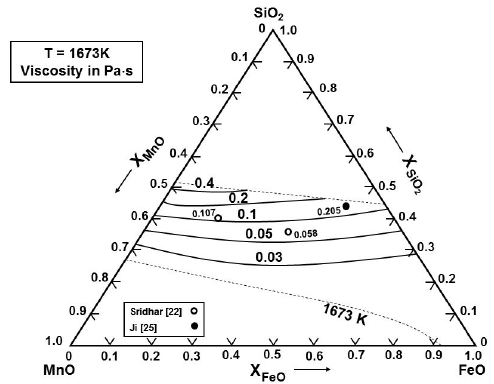
−MnO−FeO melts at 2